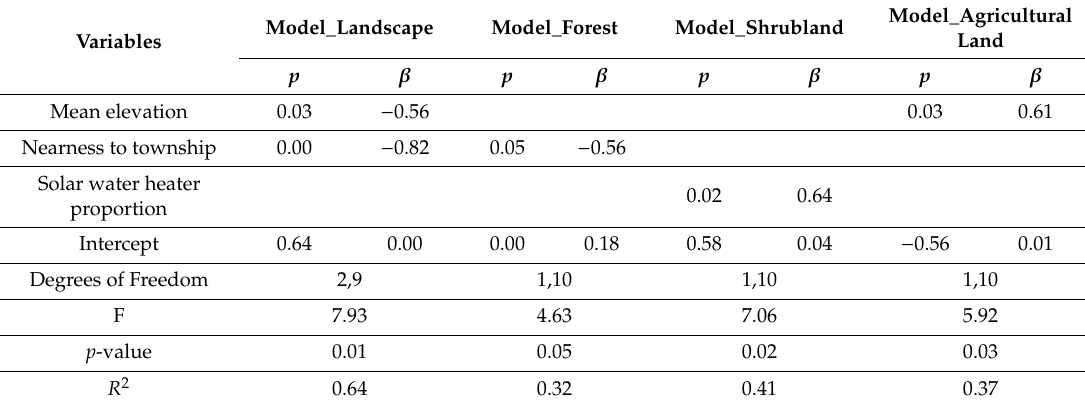
Table 9. Stepwise regression analyses: change rate in class / landscape fragmentation regressed on socioeconomic–ecological variables from 2010 to 2014, N =